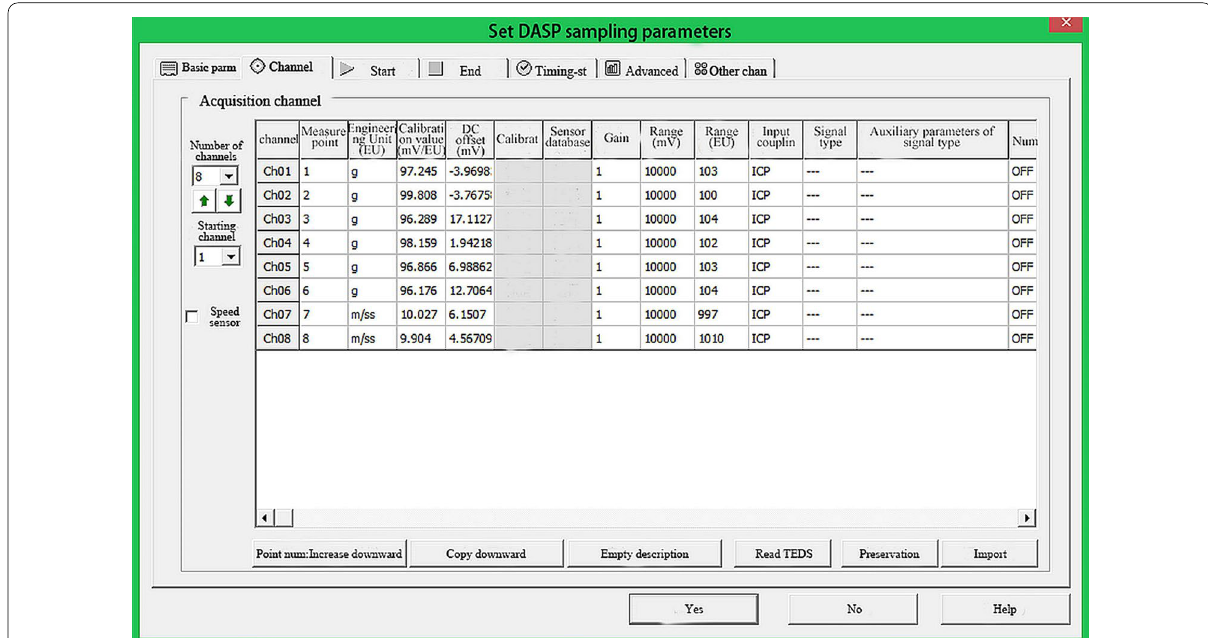
Figure 6 DASP collector control interface